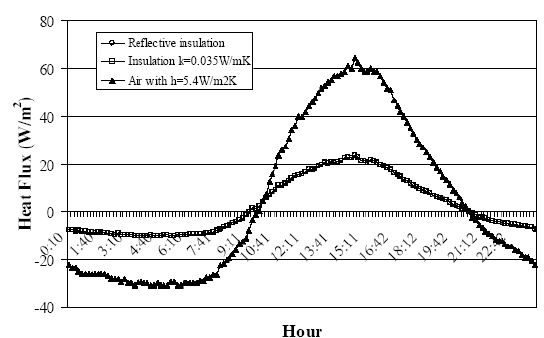
Figure 12. Temperature distribution inside and outside at west wall Summer period .